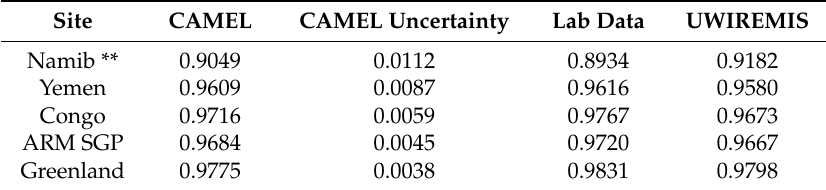
Table 2. CAMEL 8.0–13.5 µ m BBE Uncertainty and Validation at Case